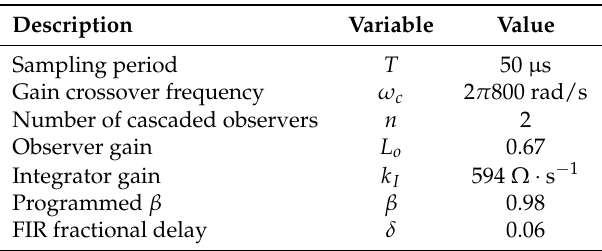
Table 2. IPCC control